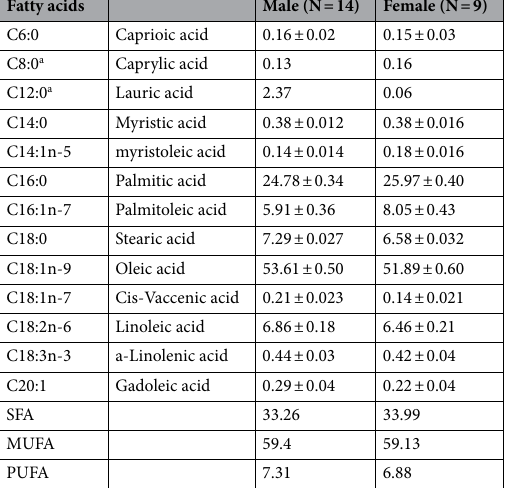
Table 9. Fatty acid profile of emu fat collected in November. a Sample size too small for statistical analysis.